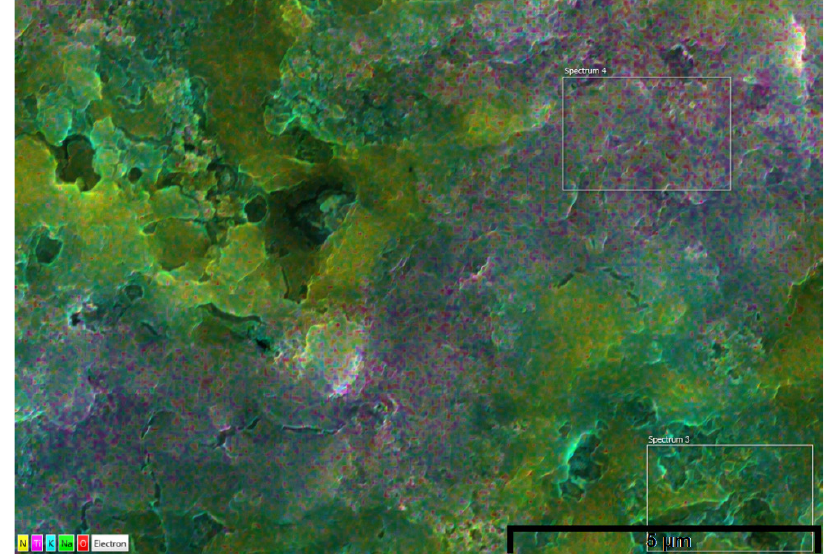
Figure 5. EDX mapping of 0.1 wt % TiO 2 (Yellow—Nitrogen, Violet—Titanium, Blue— Potassium, Green—Sodium, and